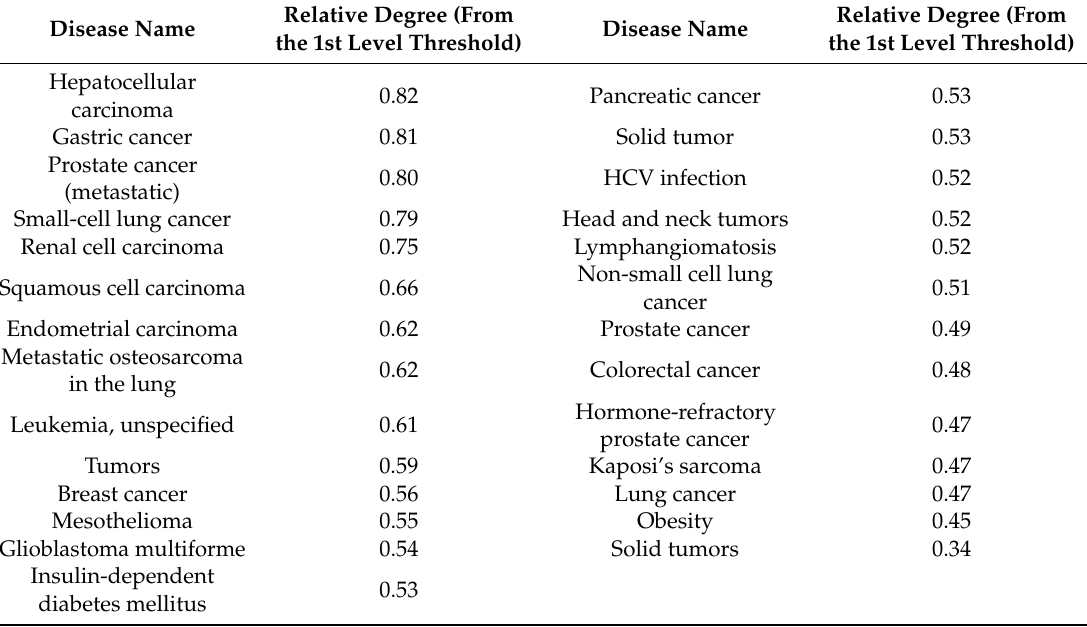
Table 4. The potential target diseases based on the relative degree matrix of Platycodon grandiflorum . HCV—hepatitis C